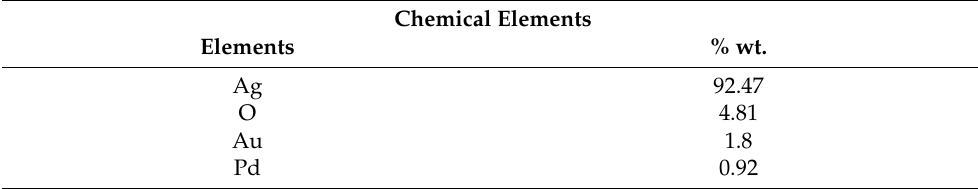
Figure 11. SEM–FEG of agglomerated particles in the PVA film with 10% wt. Ag. Table 8. Chemical elements detected by EDS .